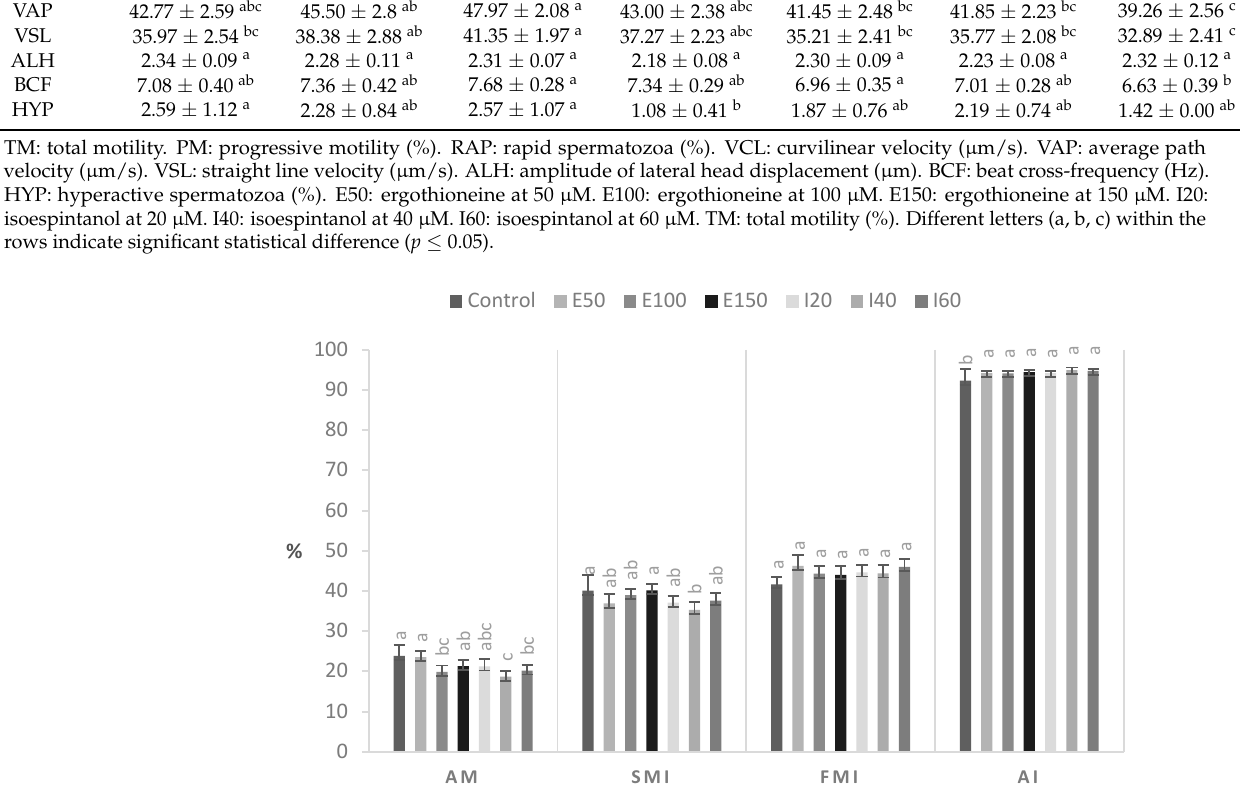
Figure 1. Morphology and membrane integrity of frozen-thawed canine semen. E50: ergothioneine at 50 µ M. E100: ergothioneine at 100 µ M. E150: ergothioneine at 150 µ M. I20: isoespintanol at 20 µ M. I40: isoespintanol at 40 µ M. I60: isoespintanol at 60 µ M. AM: abnormal morphology. SMI: Structural membrane integrity. FMI: Functional membrane integrity. AI: Acrosomal membrane integrity. Bars represent the mean ± standard error of the mean (SEM). Different letters (a, b, c) between bars indicate significant statistical difference ( p ≤ 0.05). The mitochondrial activity of thawed canine sperm is expressed as ΔΨ M (Figure 2), from the green fluorescence of JC-1 monomers (Low- ΔΨ M), the red fluorescence due to the dimerization of JC-1 (High- ΔΨ M), and their relationship (red: green ratio). The mito- chondrial membrane potential of cryopreserved canine semen was not affected by either antioxidant. Figure 3 shows that E100, I40, and I60 reduced ROS production in thawed canine semen.